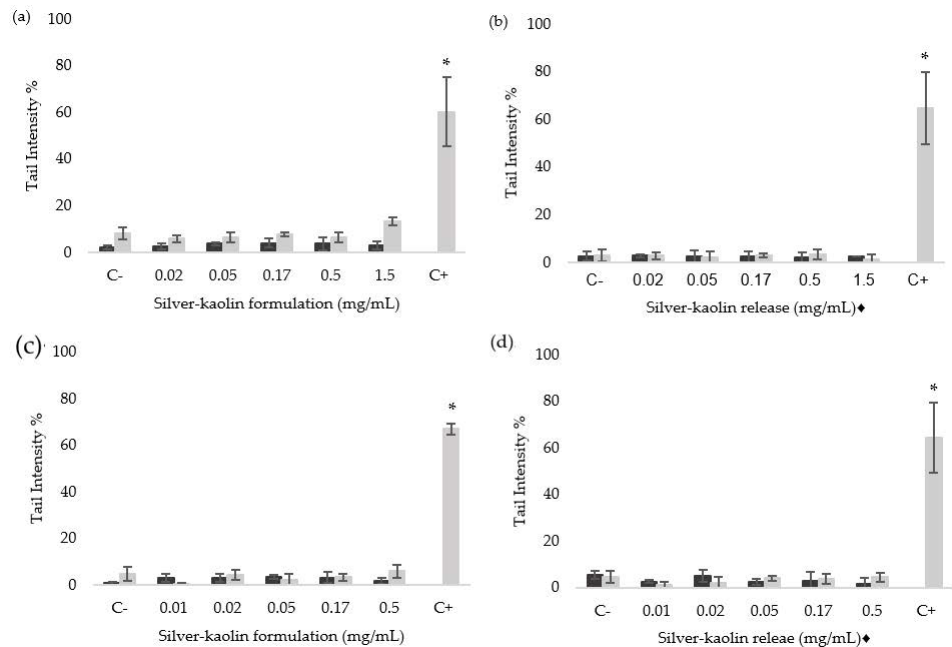
Figure 4. Results of comet assays after 3 h treatment with silver-kaolin formulation ( a ), 3 h treatment with the corresponding silver-kaolin release ( b ), 24 h treatment with silver-kaolin formulation ( c ), and 24 h treatment with the corresponding silver-kaolin release ( d ). Each figure shows the induction of DNA damage as SBs and ALS (black bars) and oxidized bases (Fpg-sensitive sites, grey bars) in TK6 cells, represented as % DNA in tail. Negative control (C − ): untreated cells. Positive control (C+) treatment: cells treated with 1.25 mM KBrO 3 for 3 h. The results of three independent experiments are represented in each case as mean ± SD. *: statistically significant difference from negative control ( p < 0.05). (cid:7) The concentrations indicated correspond to the silver-kaolin formulation that was in agitation for 24 h (see Section